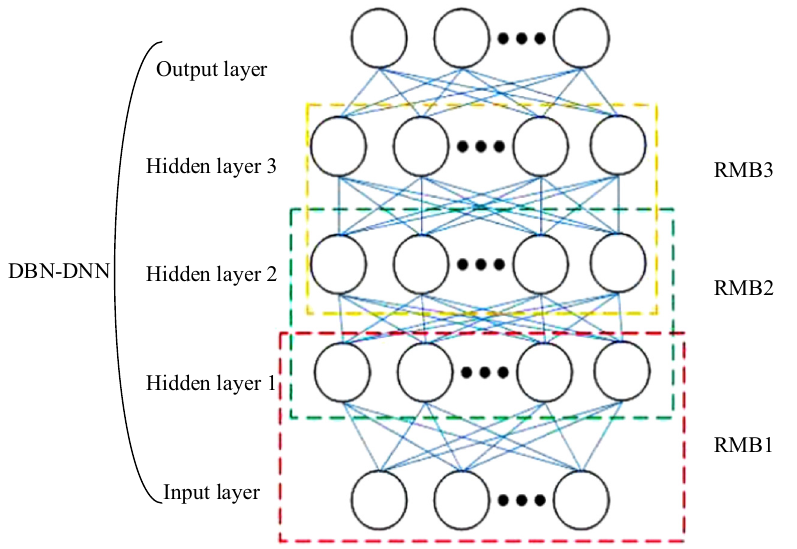
Figure 3: The model structure of the RBM